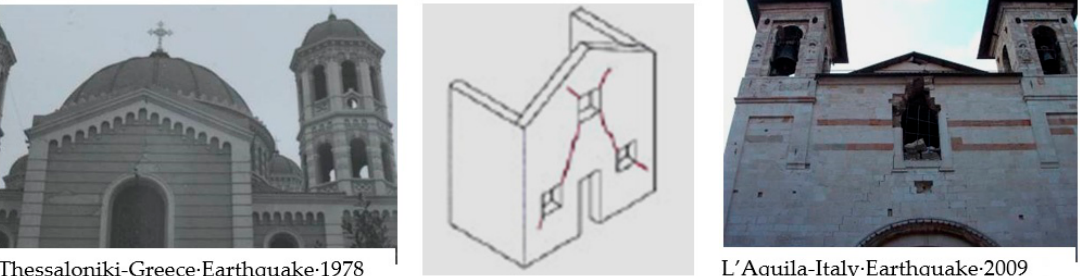
Figure 5. Typical damage patterns of longitudinal walls.